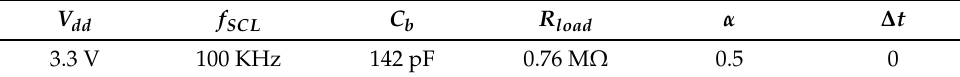
Table 2. Simulation parameters.